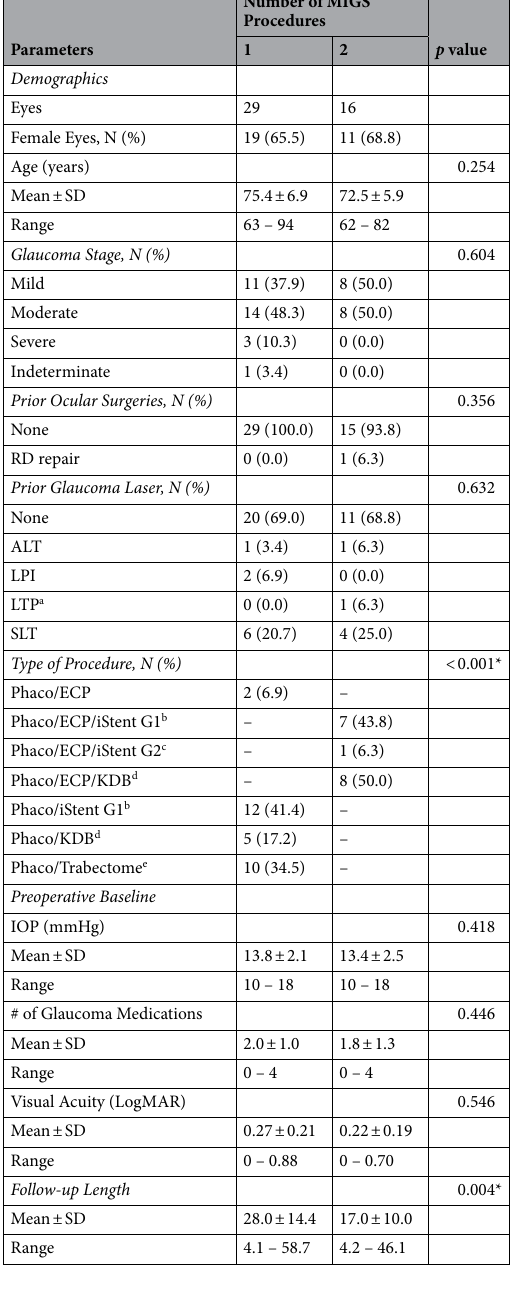
Table 4. Demographic characteristics and preoperative data for eyes stratified by 1 or 2 MIGS procedures. N = number of eyes; SD = standard deviation; IOP = intraocular pressure; ALT = argon laser